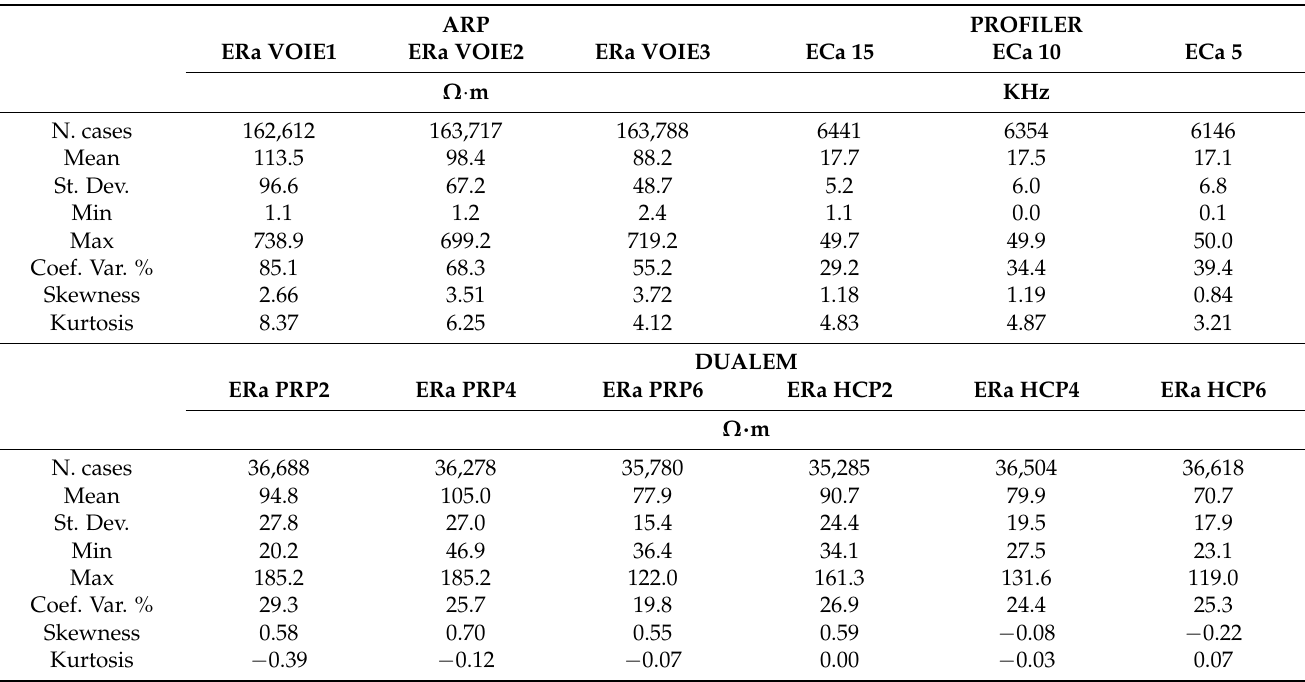
Table 1. Descriptive statistics on ARP, PROFILER EMP and DUALEM data of geophysical surveys. ERa = apparent electrical resistivity; ECa = apparent electrical